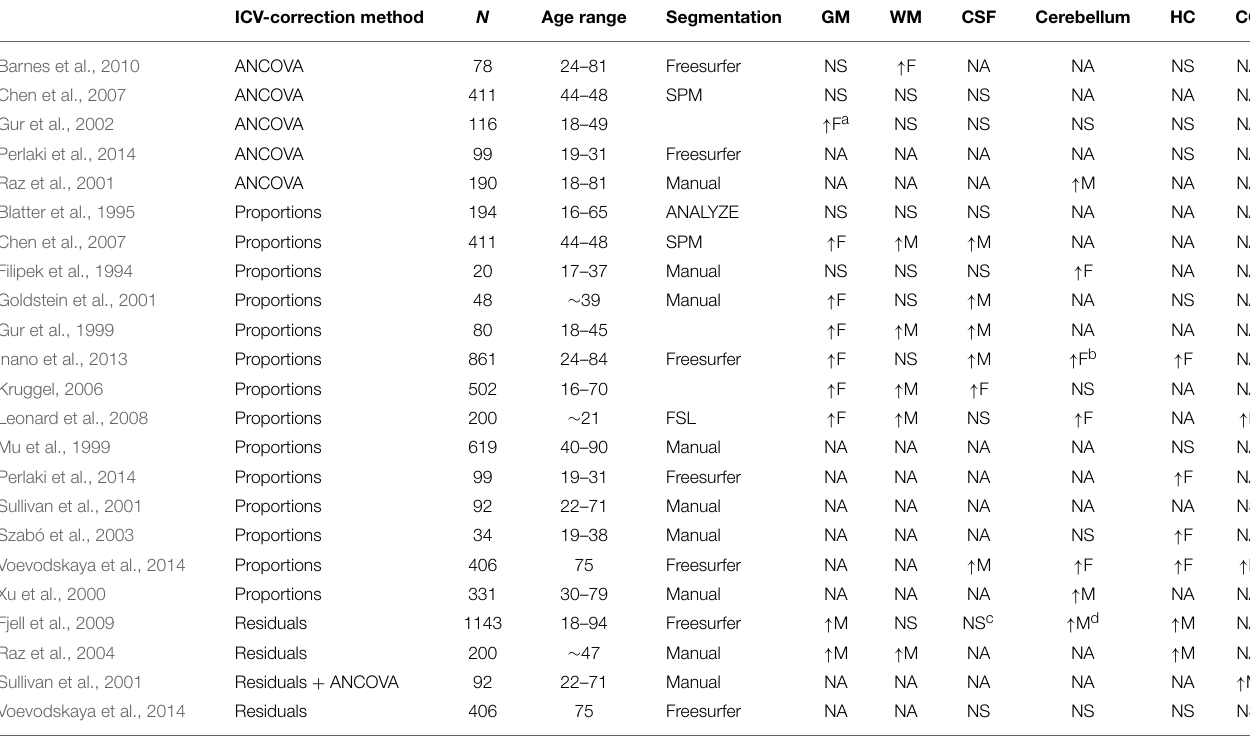
TABLE 1 | Comparison of sex differences across selected